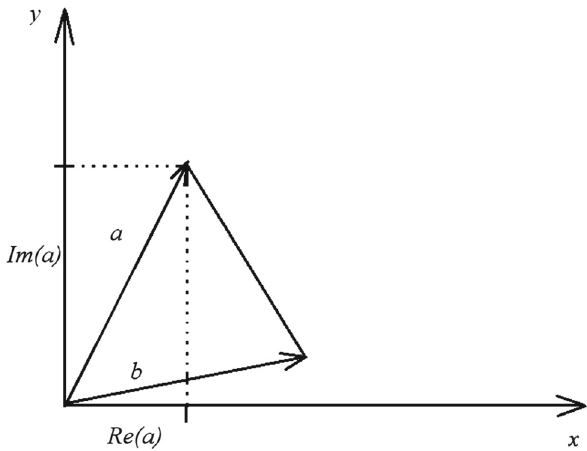
Fig. 1 Jarlskog relation presented as triangle on a complex plane in 3D